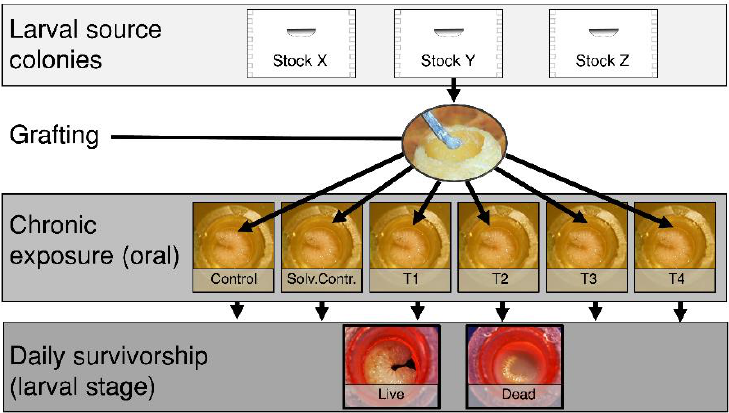
Figure 5. Graphical representation of methods.